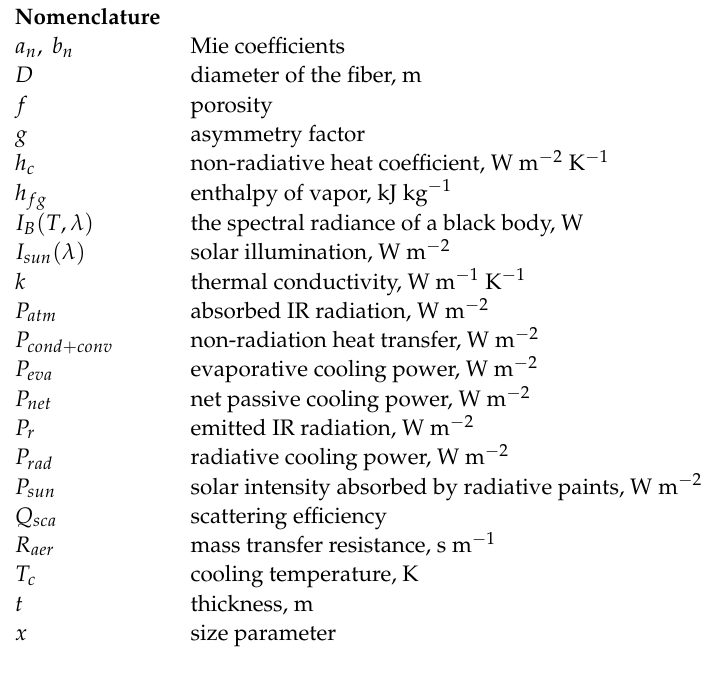
Figure S2: Simulated improved monthly temperature reduction in different representative cities; Table S1: Mean daytime meteorological parameters in July; Table S2: Monthly mean daytime meteorological parameters in Beijing (cold region); Table S3: Monthly mean daytime meteorological parameters in Harbin (severe cold region); Table S4: Monthly mean daytime meteorological parameters in Shanghai (hot summer and cold winter region); Table S5: Monthly mean daytime meteorological parameters in Kunming (temperate region); Table S6: Monthly mean daytime meteorological parameters in Haikou (hot